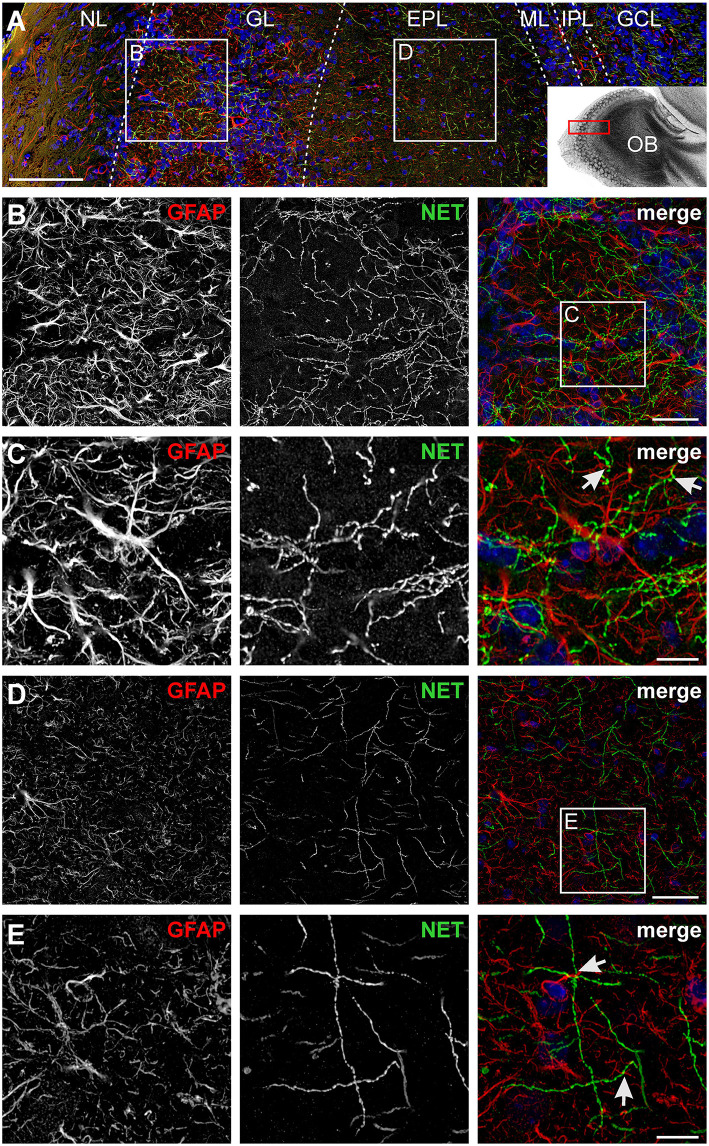
Visualization of noradrenergic fibers and astrocytes in the olfactory bulb. (A) Laminar organization of the olfactory bulb. Astrocytes were labeled by GFAP immunostaining (red), noradrenergic fibers were visualized by staining of the norepinephrine transporter (NET; green). Nuclei were stained with Dapi (blue). NL, nerve layer; GL, glomerular layer; EPL, external plexiform layer; ML, mitral cell layer; IPL, internal plexiform layer; GCL, granule cell layer. Scale bar: 100 μm. The inset depicts the location of the section in the olfactory bulb. (B) Astrocytes and noradrenergic fibers in the GL. Scale bar: 20 μm. (C) Magnified view of the GL. Astrocytes and noradrenergic fibers strongly intermingle, bringing astrocytic processes, and noradrenergic varicosities closely together (arrows). Scale bar: 5 μm. See also Supplementary Figure 1. (D) Astrocytes and noradrenergic fibers in the EPL. Scale bar: 20 μm. (E) Magnified view of the EPL. Arrows point to astrocyte processes adjacent to varicosities. Scale bar: 5 μm. All images represent projections of image stacks spanning 8 μm in depth.